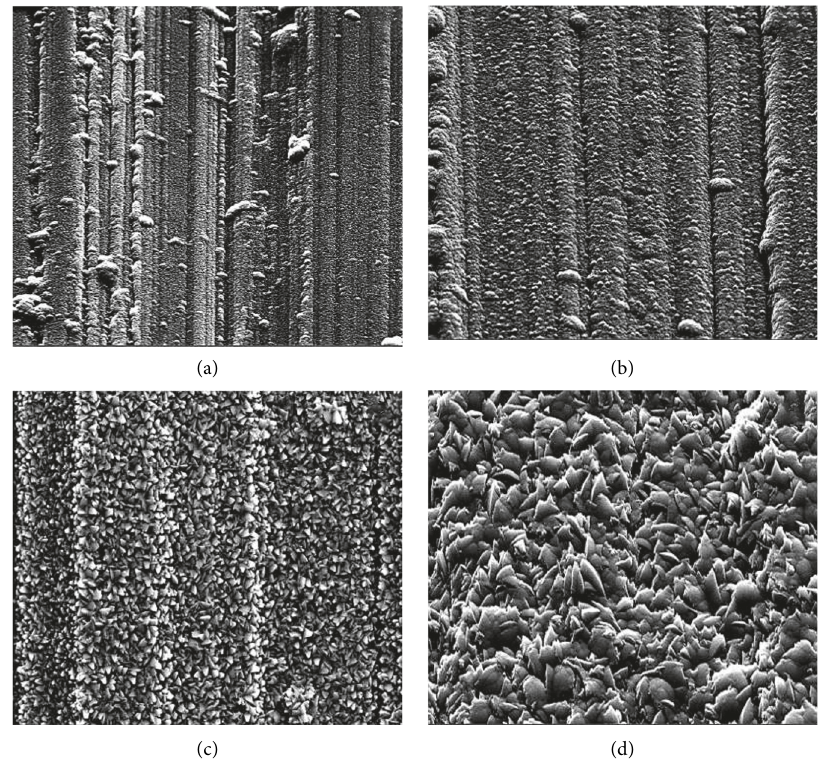
Figure 4: SEM image of surface morphology ( × 20000): (a) 30min 100W; (b) 90min 100W; (c) 30min 300W; (d) 90min 300